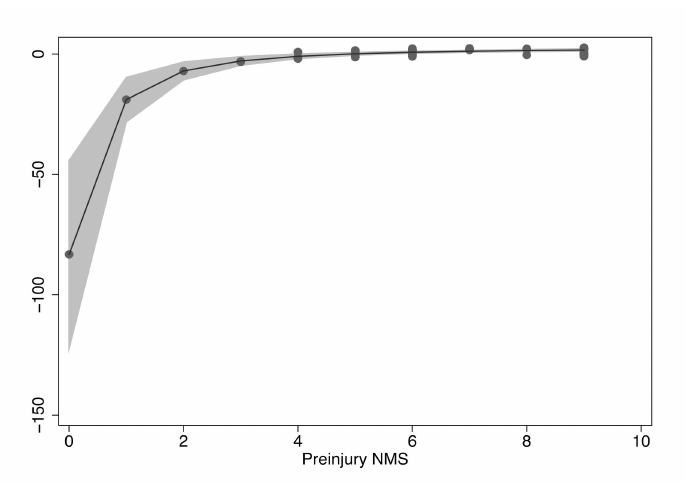
Figure A1. The shape of the association between ambulatory status and pre-injury NMS in the most fitted second-degree fractional polynomials term.